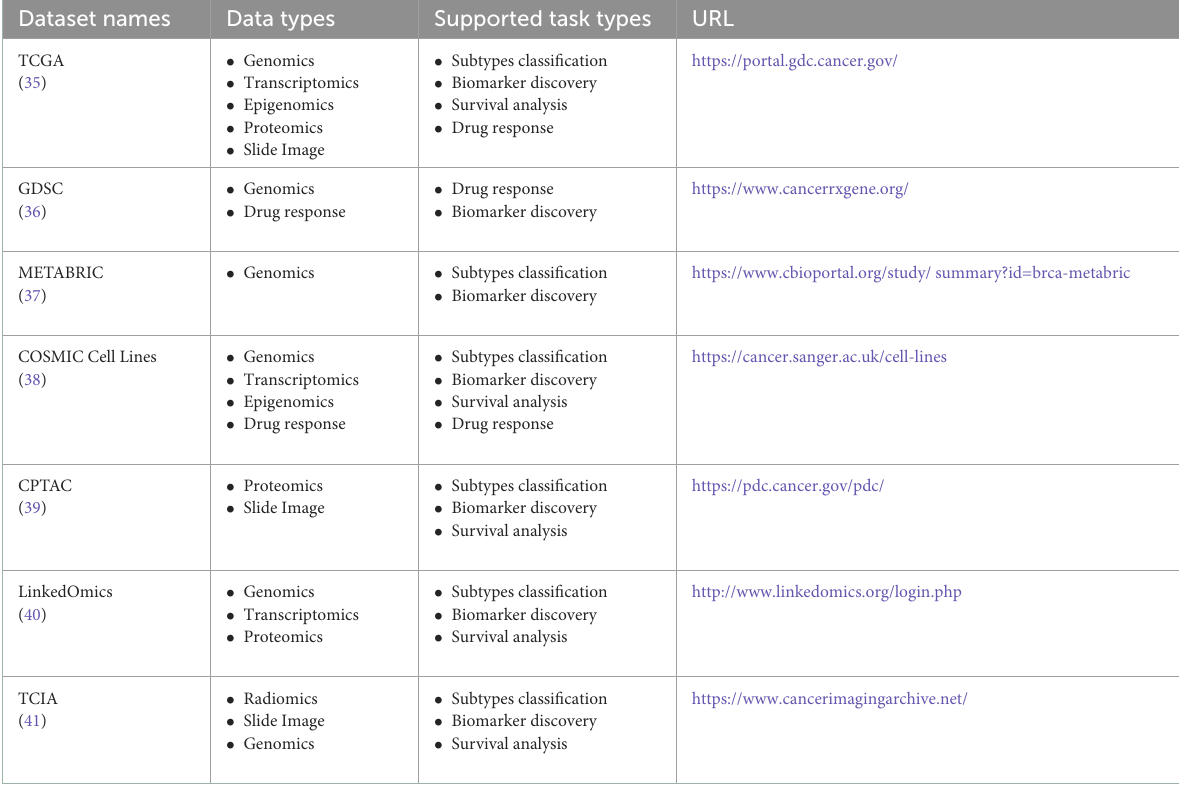
TABLE 1 Frequently used multi-omics